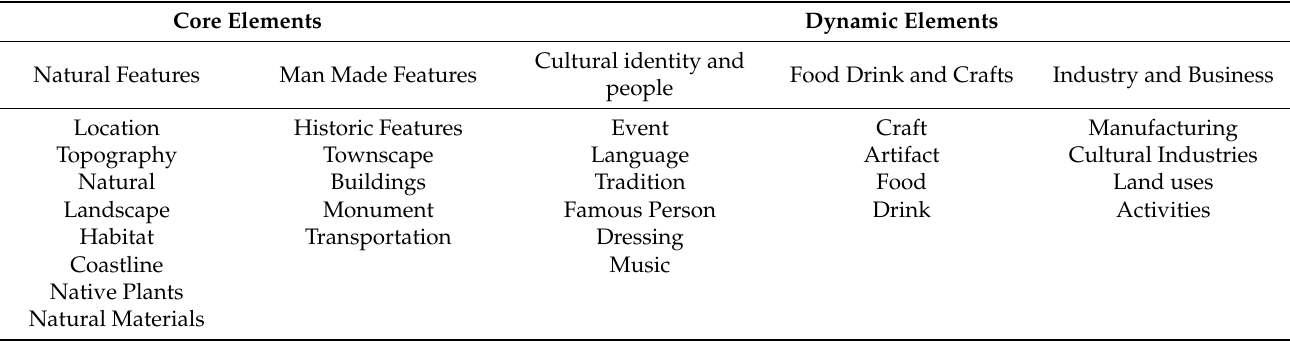
Table 1. Description of local distinctiveness elements (El Hosary et al. 2018).